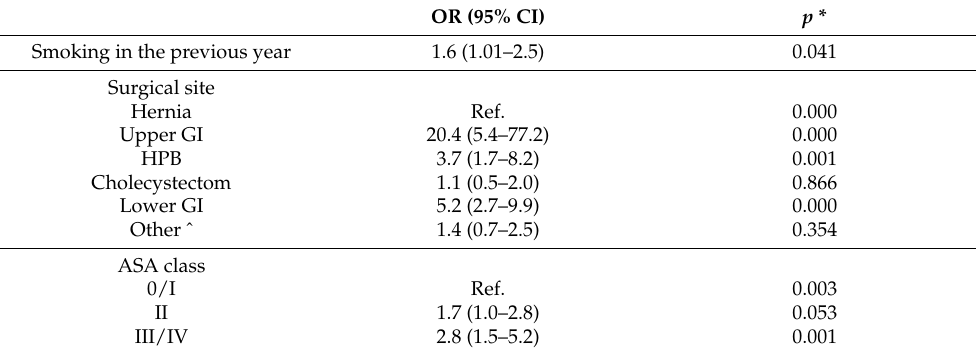
Table 2. Multiple regression analysis of factors associated with malnutrition risk (MUST score ≥ 1) in older patients undergoing surgery.